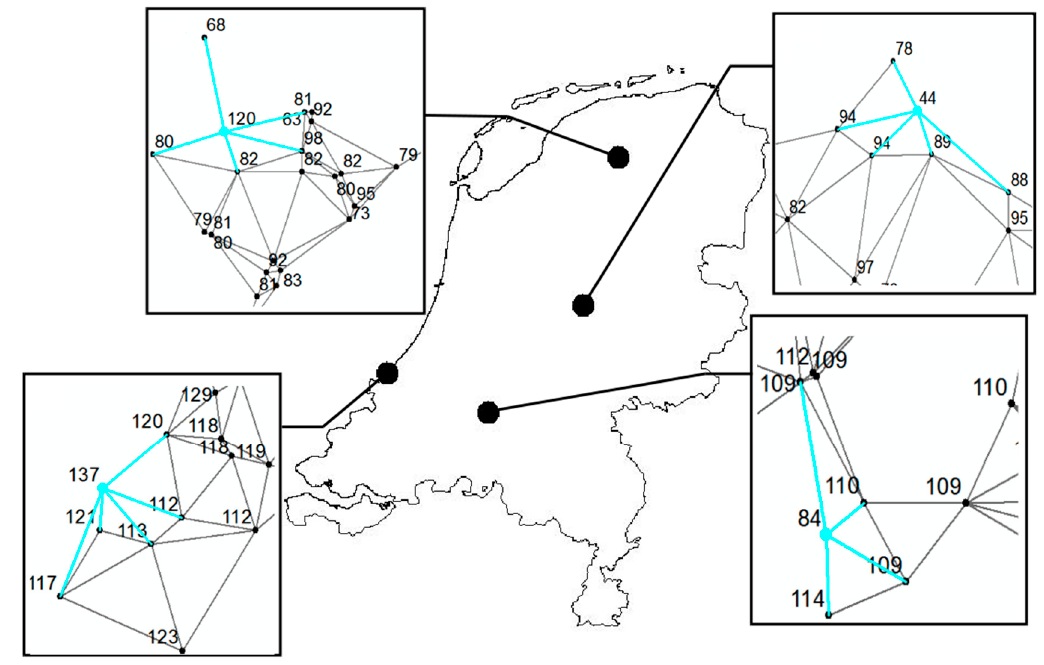
Figure 5. Examples of inconsistent observations for the flowering onset of lesser celandine. The highlighted observation is refuted by more than one other observation. Given the difference in GDDs between the highlighted observation and those connected to it, their difference in DOY exceeds the predicted difference by about two weeks. The numbers next to each observation show the reported DOYs.